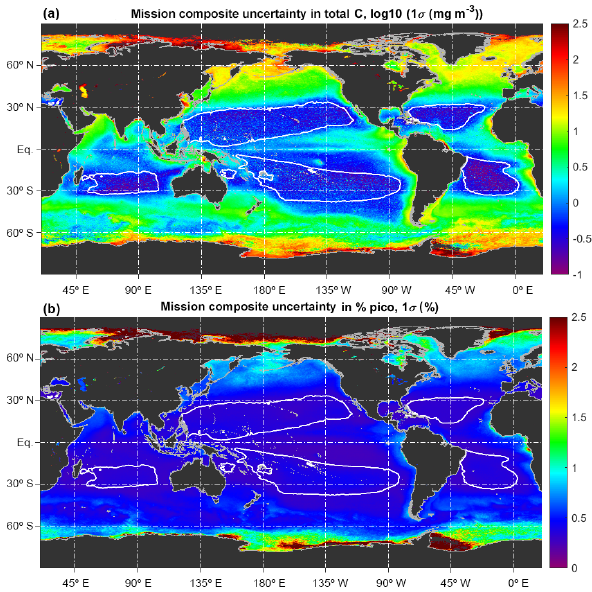
Figure 8. (a) Propagated uncertainty in the mission mean of to- tal phytoplankton carbon concentration (1 standard deviation in mgCm − 3 , shown in log10 space). This is a partial uncertainty estimate due to the quantifiable PSD parameter uncertainties and the uncertainties of the allometric coefficients. Uncertainties are propagated to the individual monthly images using Eq. (S2) and then composite imagery uncertainty is estimated using Eq. (S3) (Sect. S1.4). Panel (b) is the same as (a) but shows uncertainty for the mission mean of percent picoplankton contribution to carbon biomass (1 standard deviation in